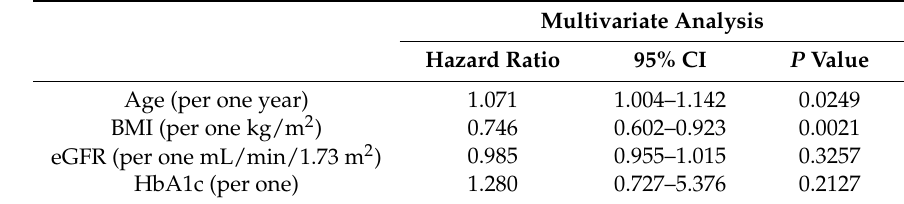
Table 7. Multivariate analyses of factors linked to the presence of sarcopenia for non-LC cases. Multivariate